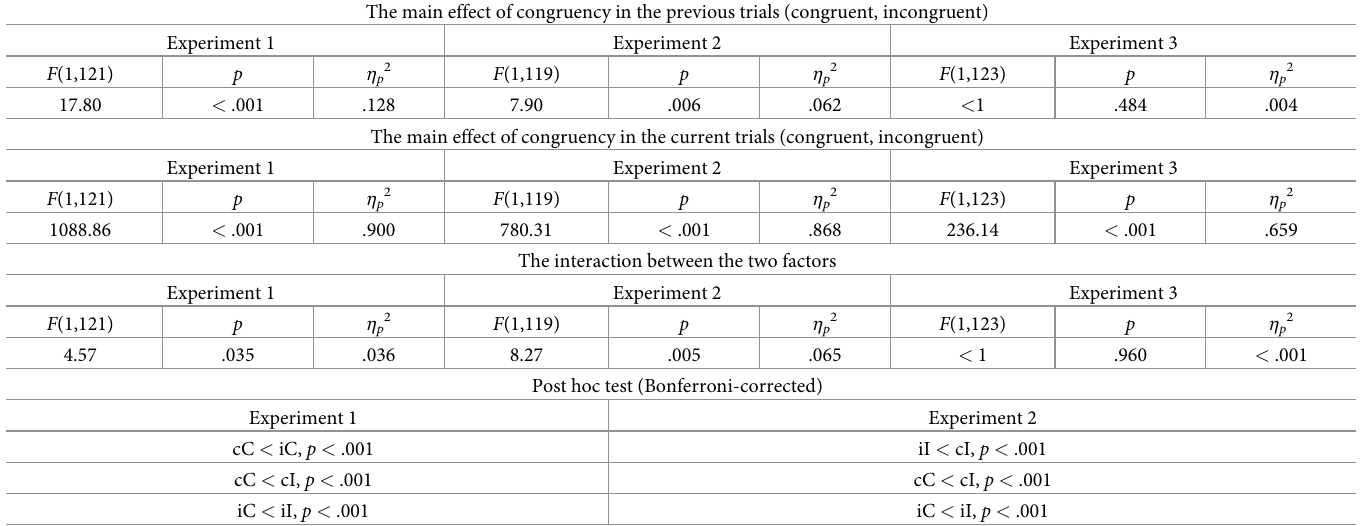
congruency (congruent, incongruent) in the previous trials and the congruency (congruent, incongruent) in the current trials, to reveal the essence of congruency sequence effect. The sig- nificance level ( p -value) was corrected using a Bonferroni method to control for the problem of multiple comparisons. Fig 2A illustrates the mean RTs in the current trials. Table 1 (the left column) shows the two-way repeated-measures ANOVA results for the mean RTs. Typically, the repeated-measures ANOVAs are based on the average of each condition for each participant. In this case, the inter-trial variability is completely blinded to the estimation of the significance of congruency sequence effect. Thus, to reveal the inter-trial variability of congruency sequence effect and to test the random factors, we used the linear mixed models to compare the RTs on the single-trial level of each condition of each participant, which included the congruency (congruent, incongruent) in both the previous and current trials as the fixed effects, and the gender (female, male) and age (continuous variable) as the random factors. The Bonferroni method was used to correct the significance level ( p value) when carrying out Table 1. Test statistics for the mean RTs in Experiments 1, 2, &